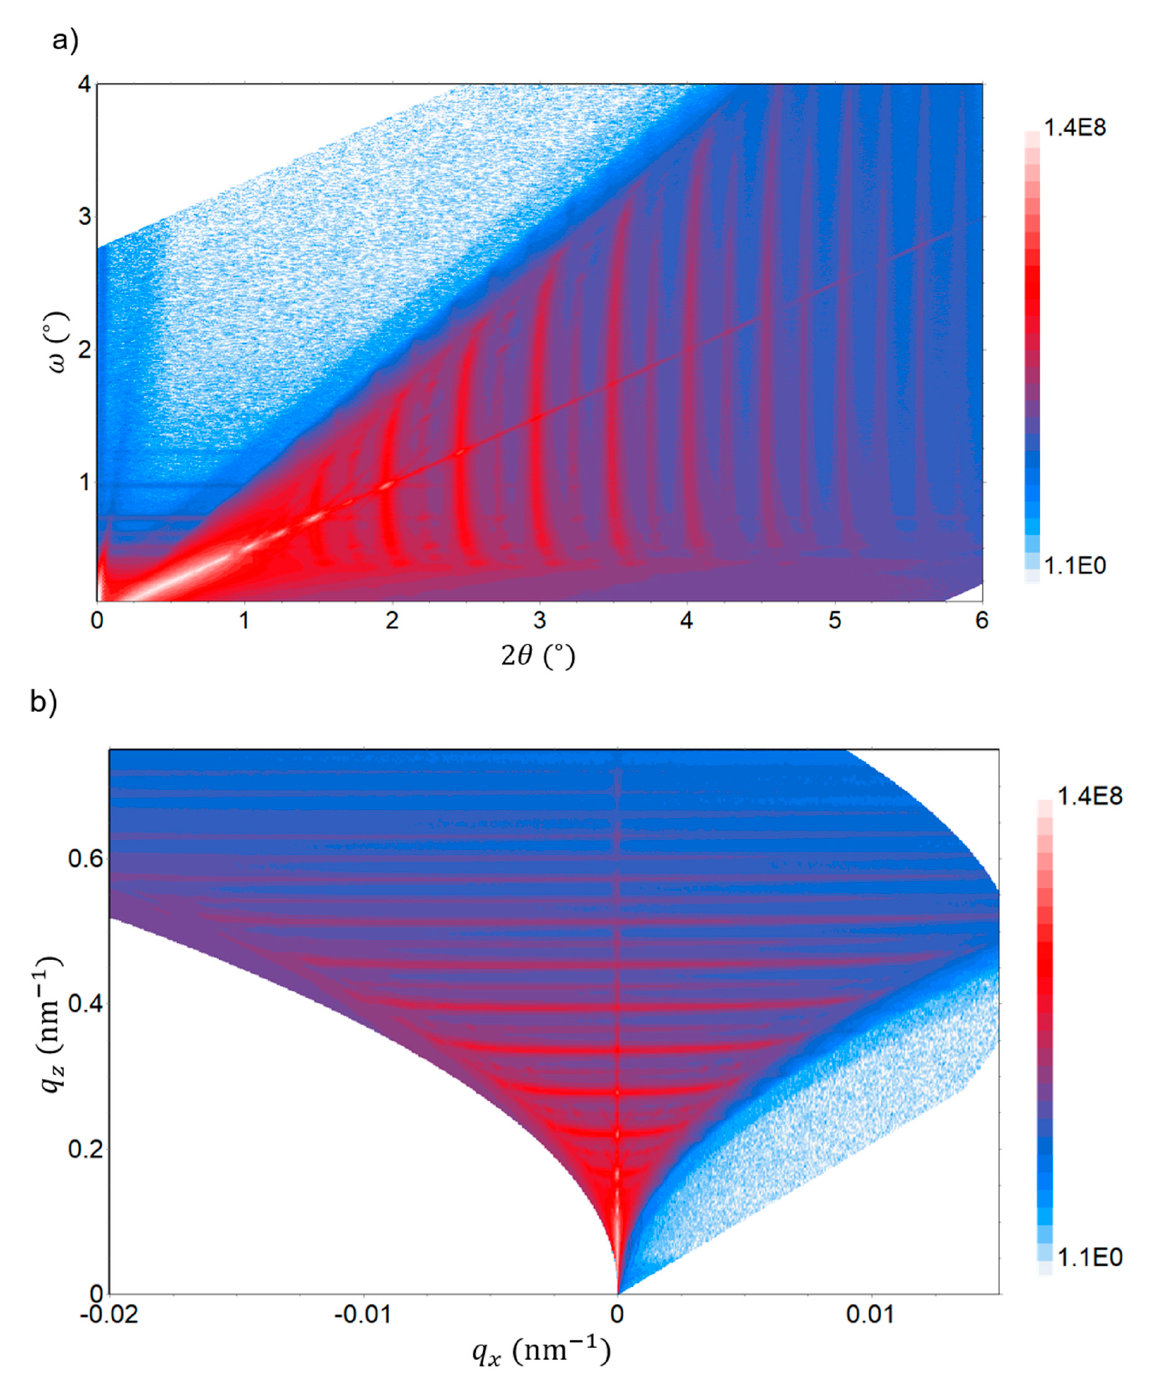
Figure 12. Rapid reciprocal space (RSM) map in the XRR regime as measured in the angular space (panel ( a )) and in the wave vector plane (reciprocal space, panel ( b )) on the C/Cu ML electrode after 542 cycles, washing, and air exposure for 15 months. The reflected X-ray intensity is represented in color entities. Several scattering features originating from dynamical X-ray scattering are visible. A color version of this figure can be viewed online.